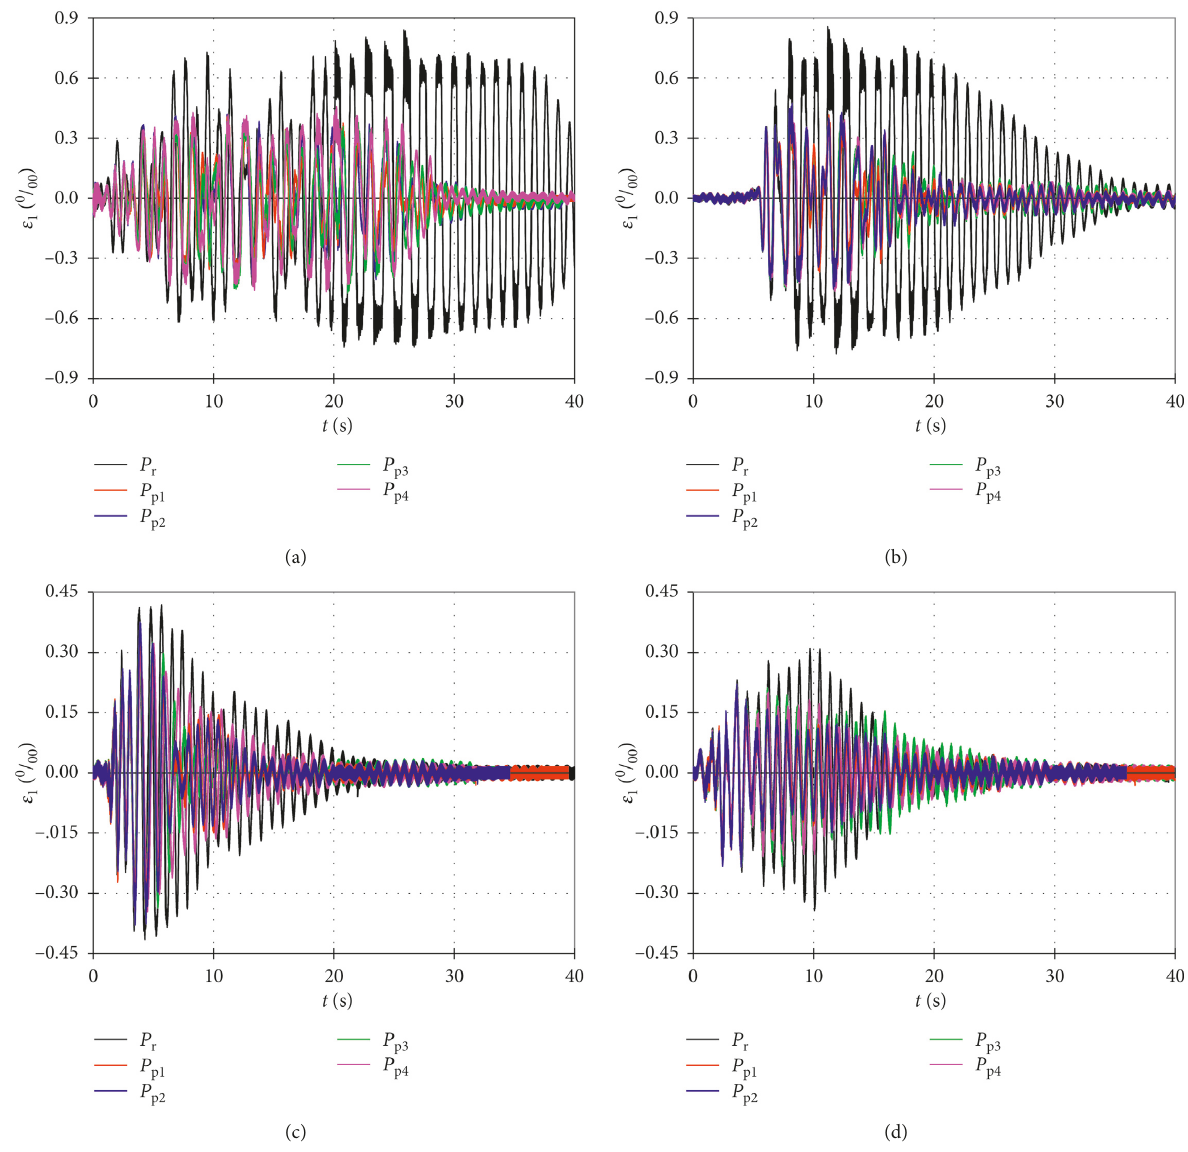
Figure 17: Vertical strain on the right bottom side of the steel column ( ε Petrovac (AP). (c) Accelerogram Ston (AS). (d) Accelerogram B. Luka